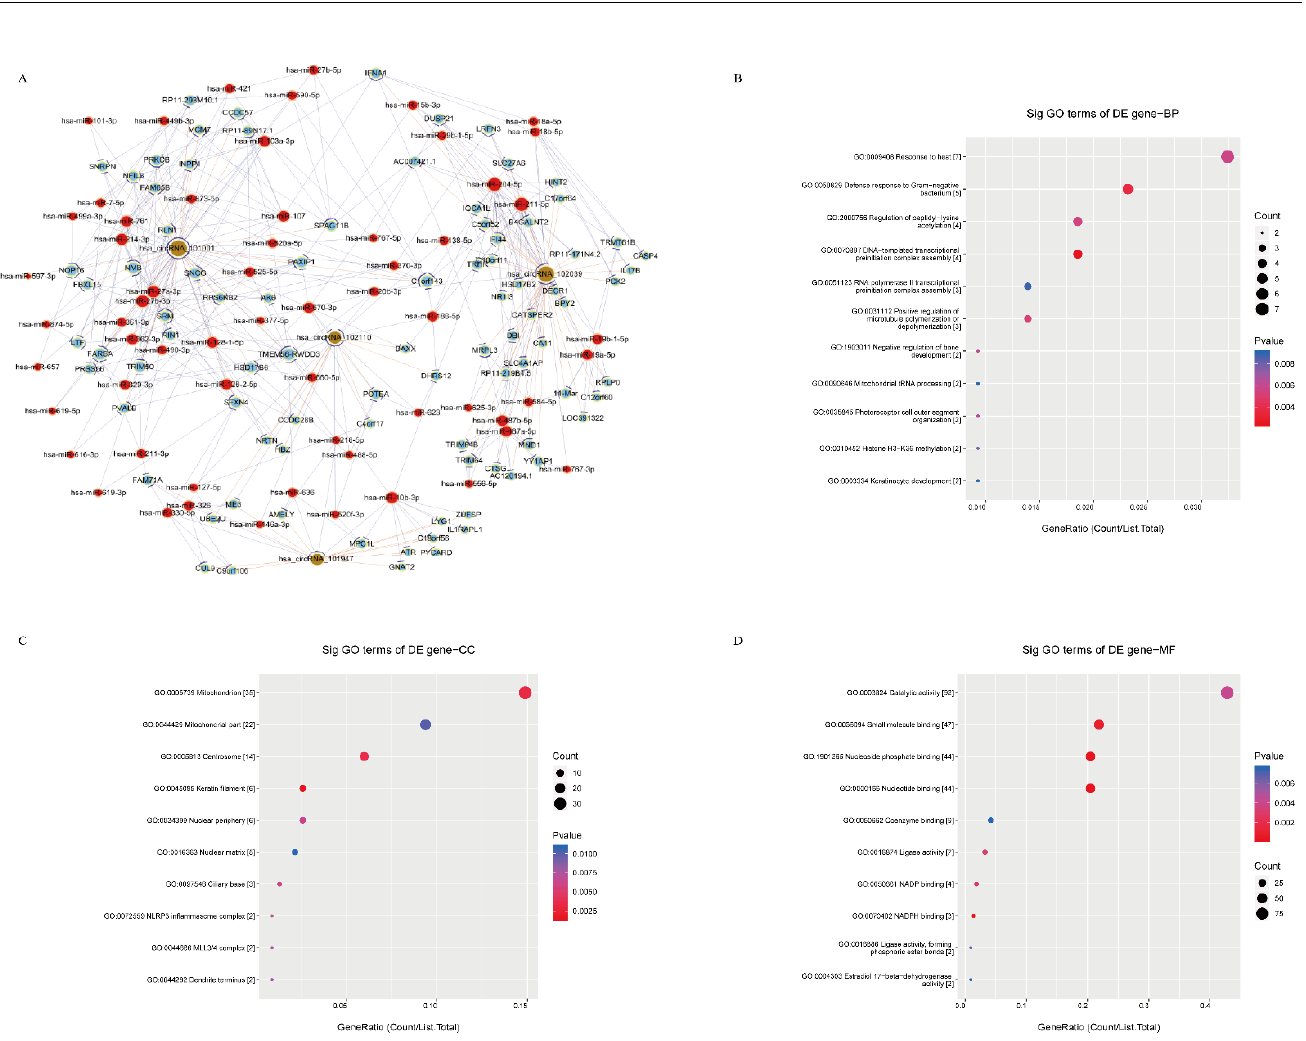
Figure 3. CeRNA network and GO analyses of shared circRNAs. ( A ) CeRNA network among hsa_circ_0043138, circRNA-0044301, hsa_circ_0041481, and hsa_circ_0025135 and their targeted miRNAs and genes (nodes: red nodes are microRNAs; light-blue nodes are protein-coding RNAs; light-green nodes are noncoding RNAs; brown nodes are circular RNAs; edges: edges with a T-shaped arrow represent direct relationships; edges without an arrow represent indirect relationships (ceRNA relationship)). ( B ) Biological processes of the four circRNAs. ( C ) Cellular components of the four circRNAs. ( D ) Molecular functions of the four circRNAs (“GO. ID” stands for the ID of the GO term; “Count” stands for the number of DE genes associated with the listed GOID; “ p value” stands for the significance testing value of the GOID; “Enrichment Score” stands for the enrichment score value of the GOID, which equals ( − log 10 ( p